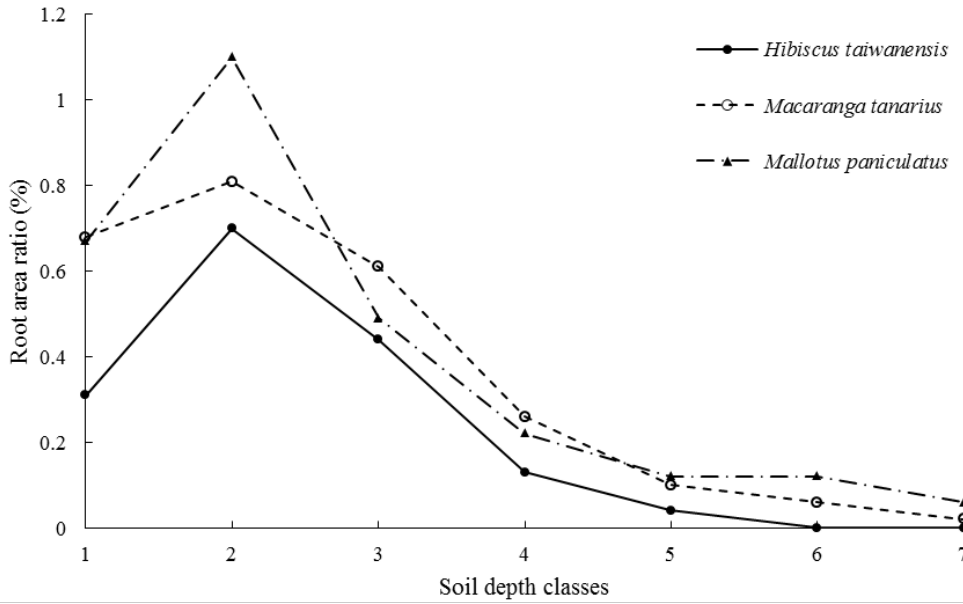
Figure 2. Root area ratio distribution with soil depth classes for the three species studied. Root